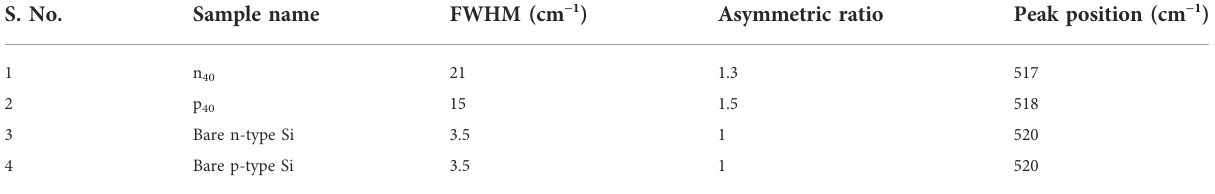
TABLE 2 Calculations of various parameters from the Raman